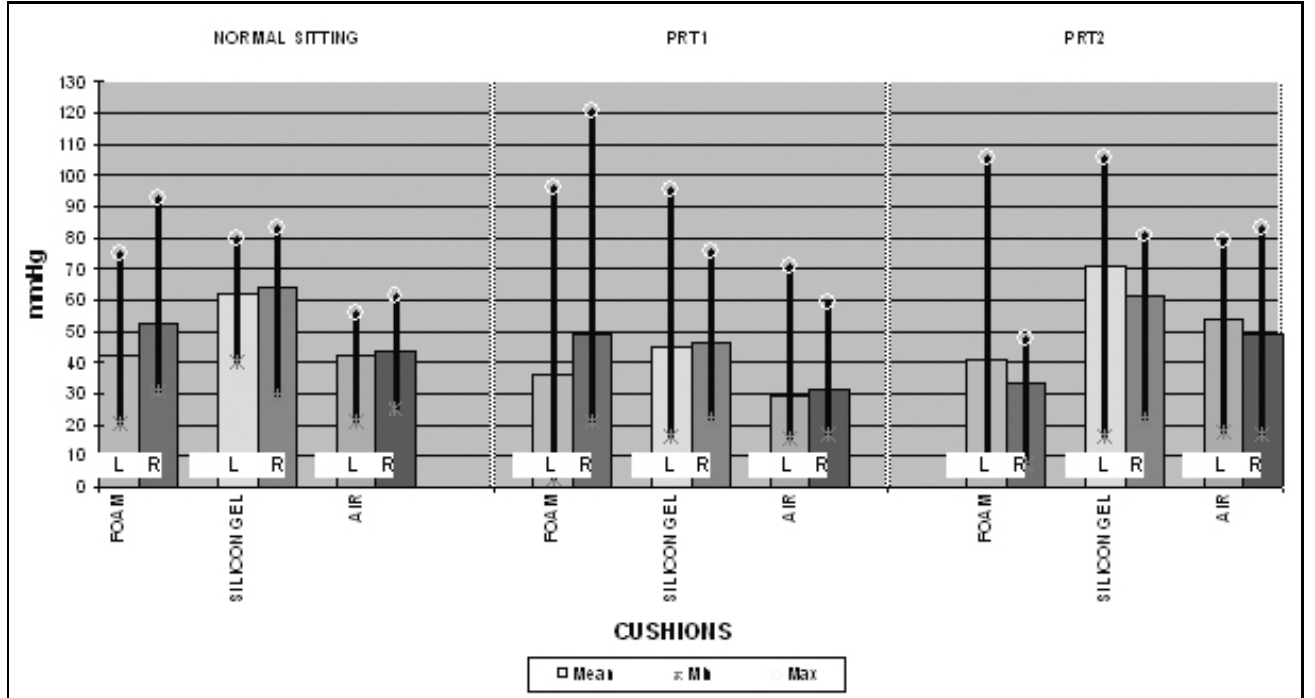
Figure 2: The six cells in matrices 1 and 3 that are situated over the ishial tuberosities on all 3 cushions in neutral sitting, PRT1 an PRT2.